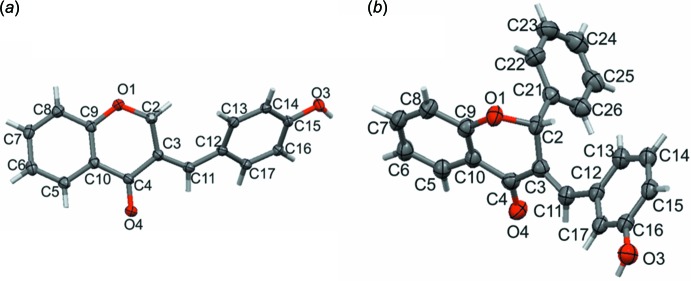
The mol­ecular structures of compounds I and II with displacement ellipsoids drawn at the 50% probability level.